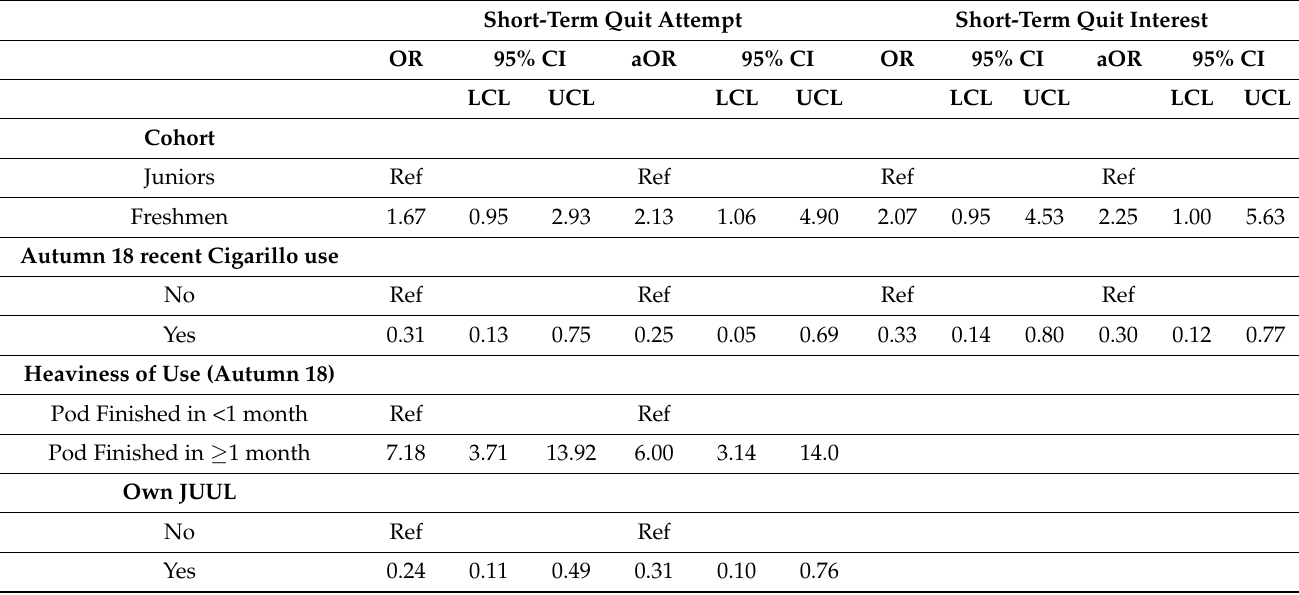
Table 3. Factors associated with short-term quit outcomes among current JUUL users. Short-Term Quit